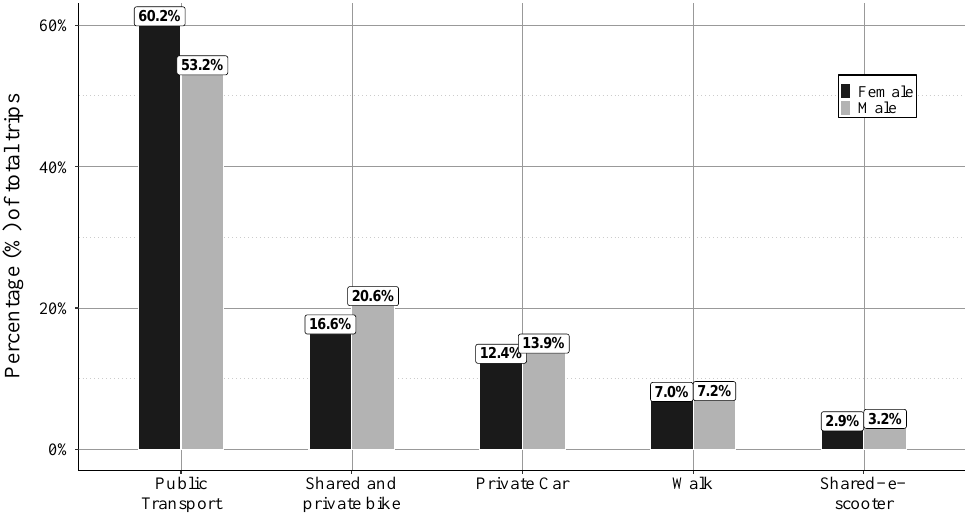
Figure 2. Main mode of transport as a percentage of total trips by gender.